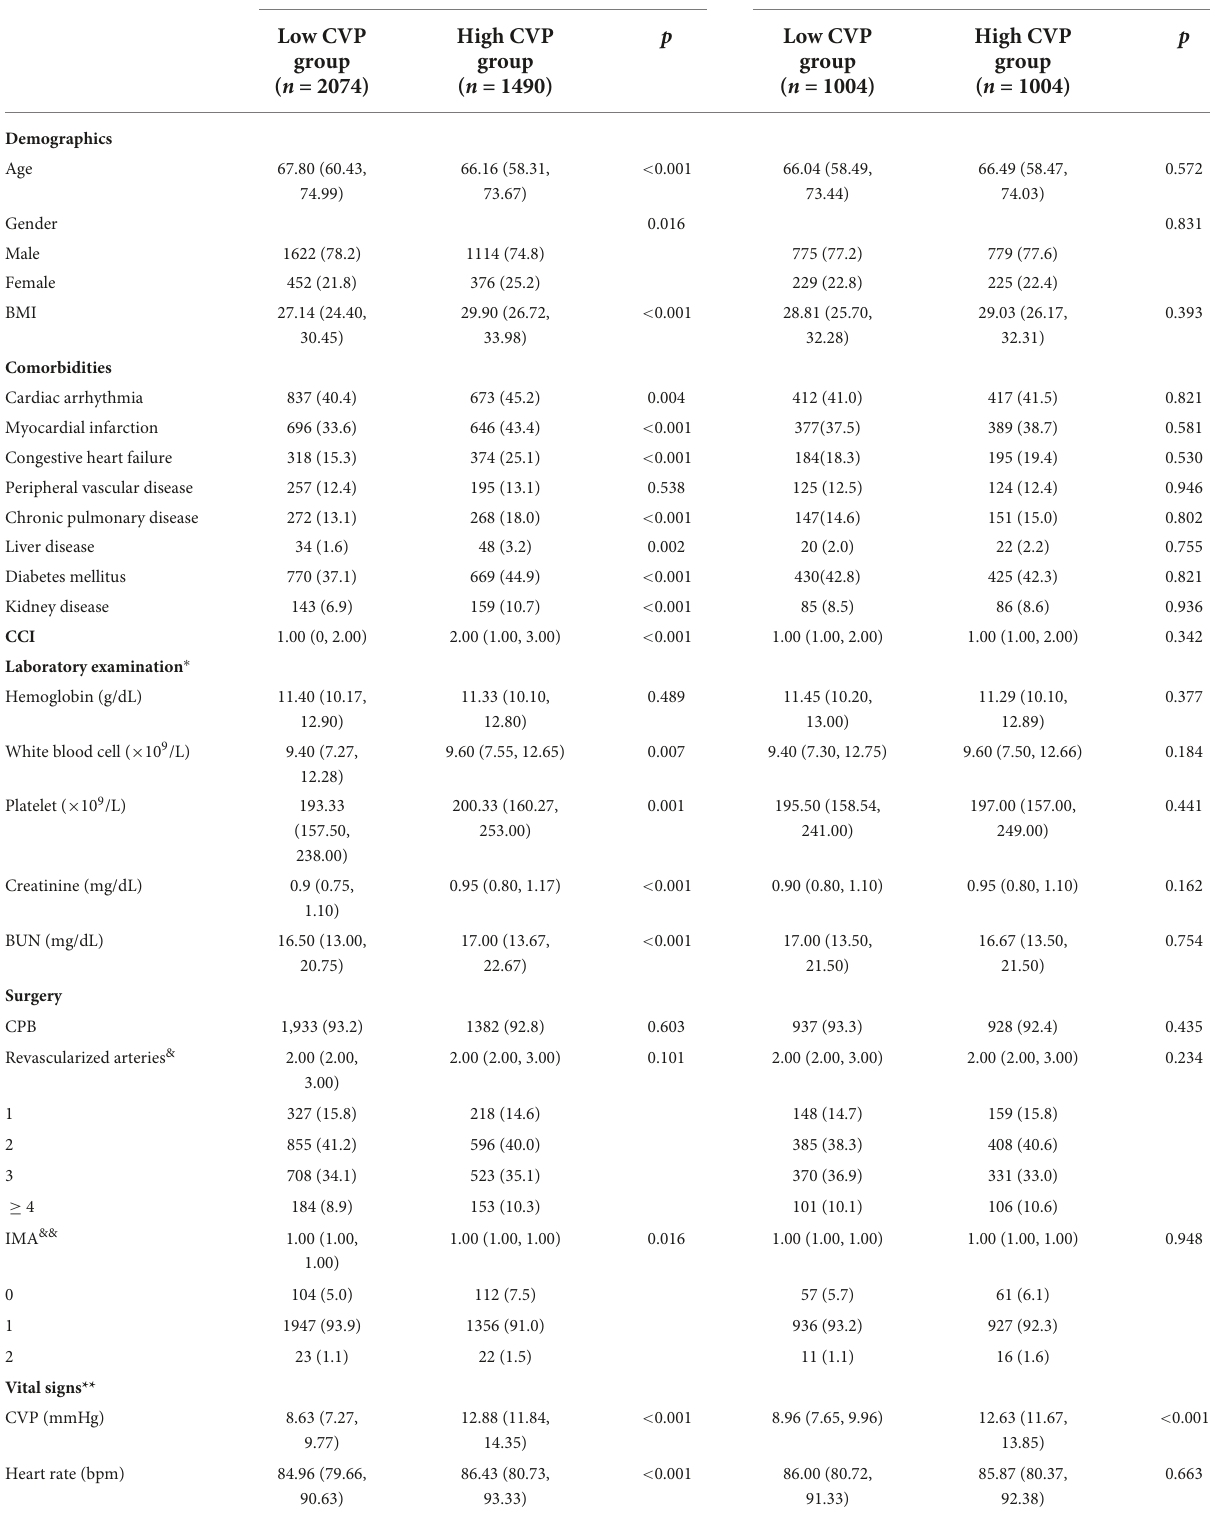
TABLE 2 Clinical characteristics of patients in different